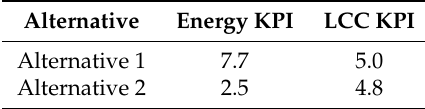
Table 8. KPI values for the running